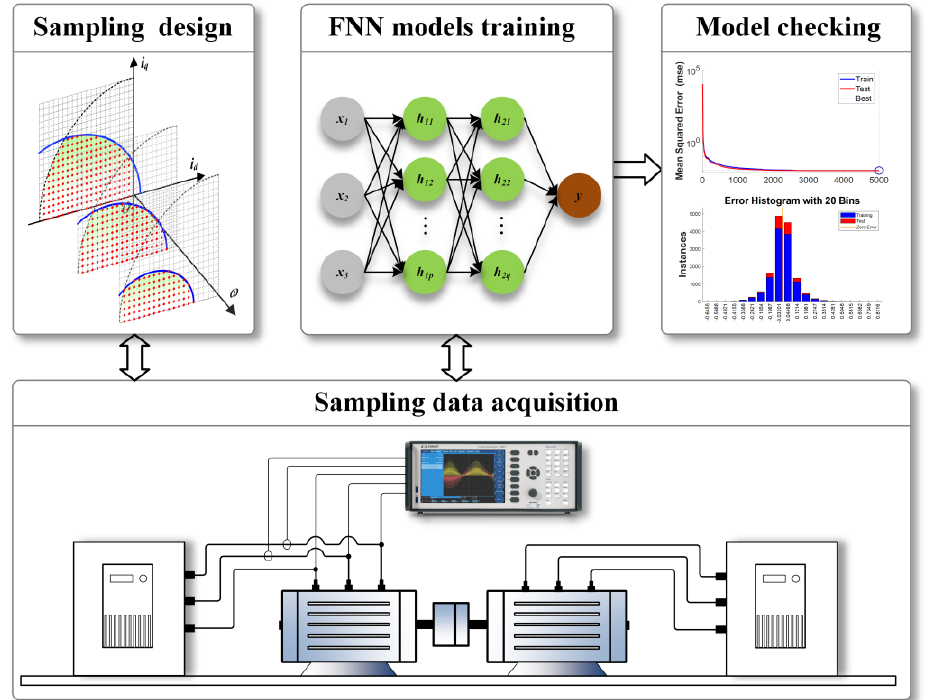
Figure 10. FNN model building process based on offline experimental sample.